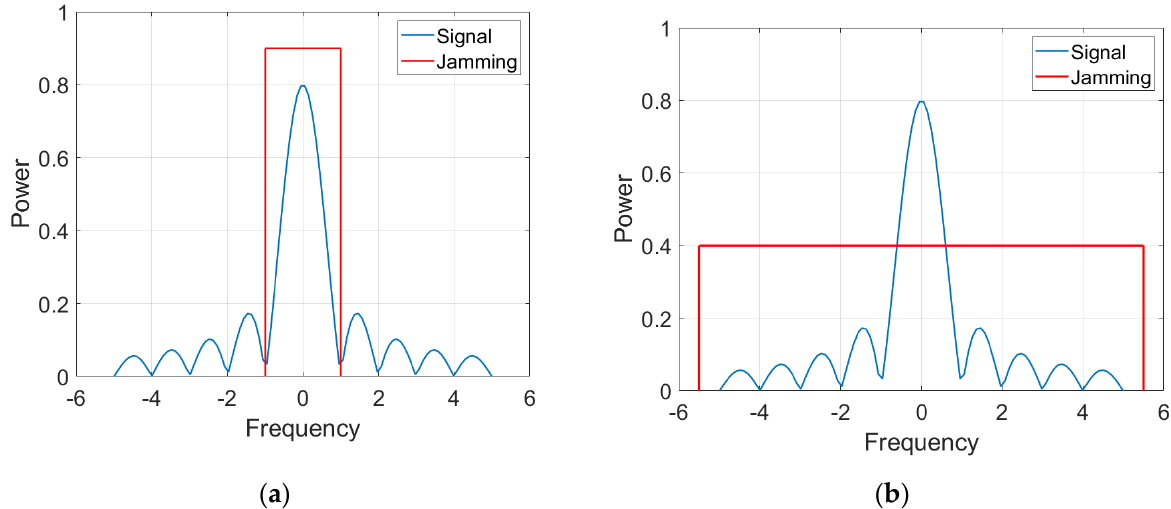
Figure 7. ( a ) Spectrum of narrowband noise jamming. ( b ) Spectrum of UWB noise jamming.